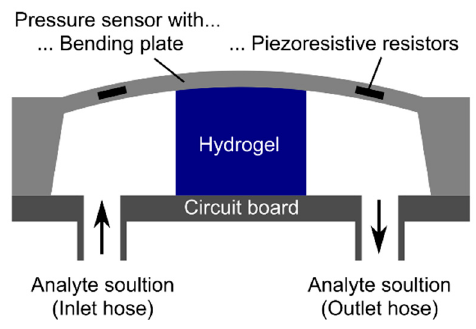
Figure 2. Schematic construction of a hydrogel-based piezoresistive pressure sensor. The figure was modified according to Erfkamp et al. [15].